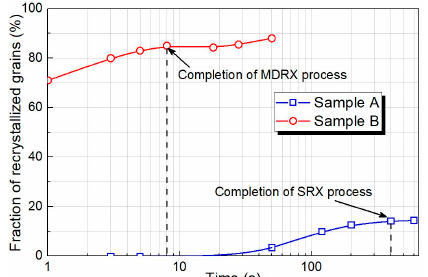
Figure 5. Variations of fraction of recrystallized grains in samples A and B with respect to holding time.